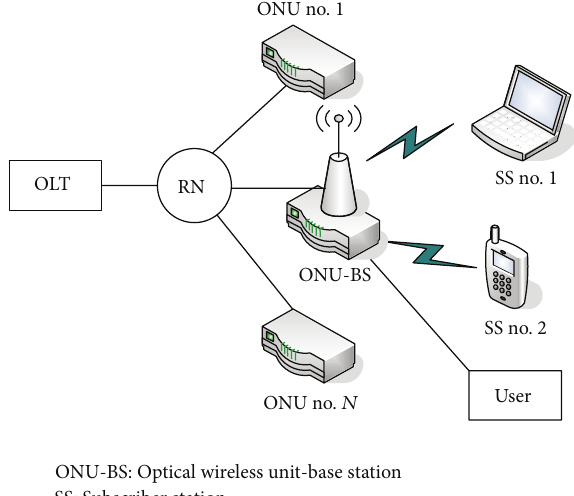
Figure 4: R&F Wi-Fi access network architecture: PON and its wireless extension